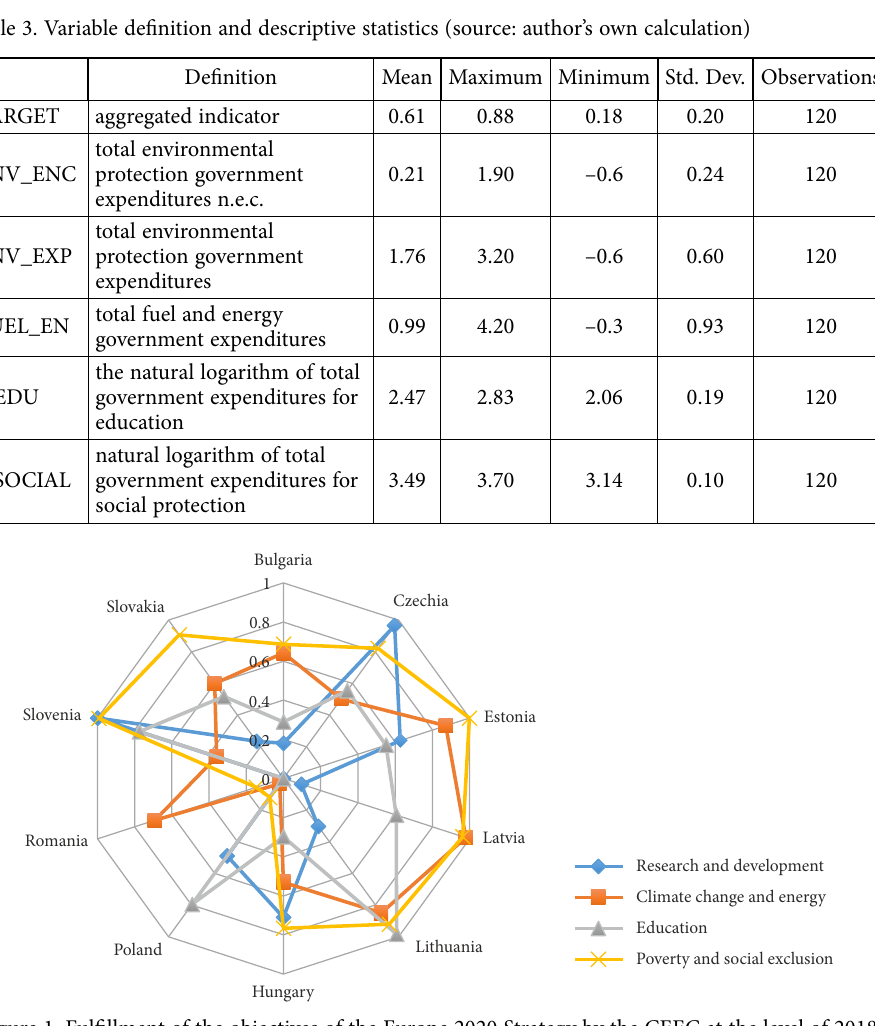
Figure 1. Fulfillment of the objectives of the Europe 2020 Strategy by the CEEC at the level of